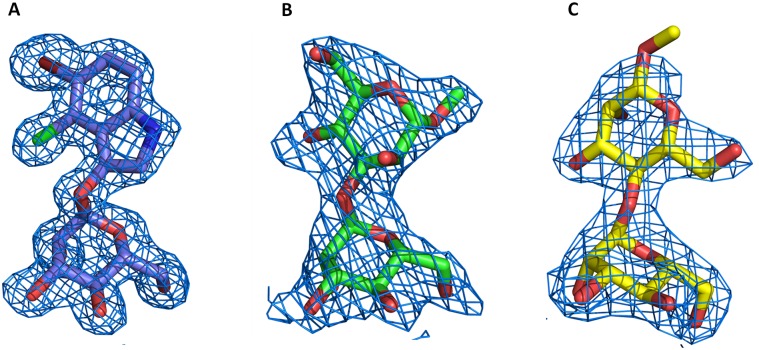
2Fobs - Fcalc electron density maps from the carbohydrates contoured at 1.0 σ.(A) Xman. (B) Man(α1-3)Man(α1-O)Me, (C) Man(α1-4)Man(α1-O)Me.